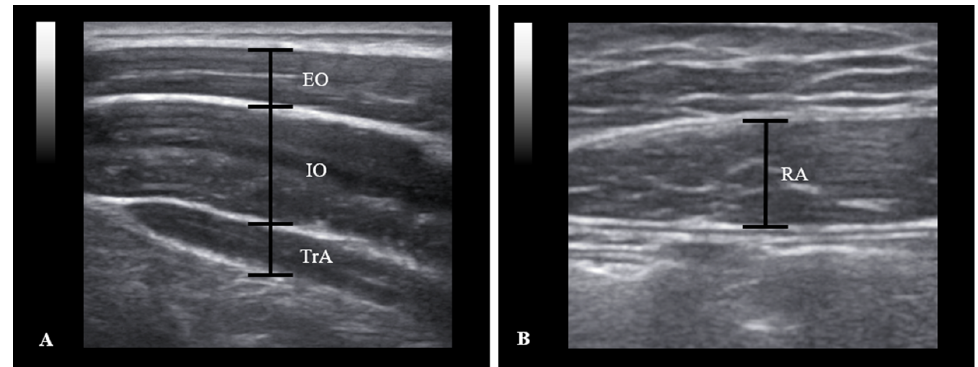
Figure 2. Abdominal muscle ultrasound image obtained in the right horizontal position. ( A ) TrA: transverse abdominis; IO: internal oblique; EO: external oblique; ( B ) RA: rectus abdominis.